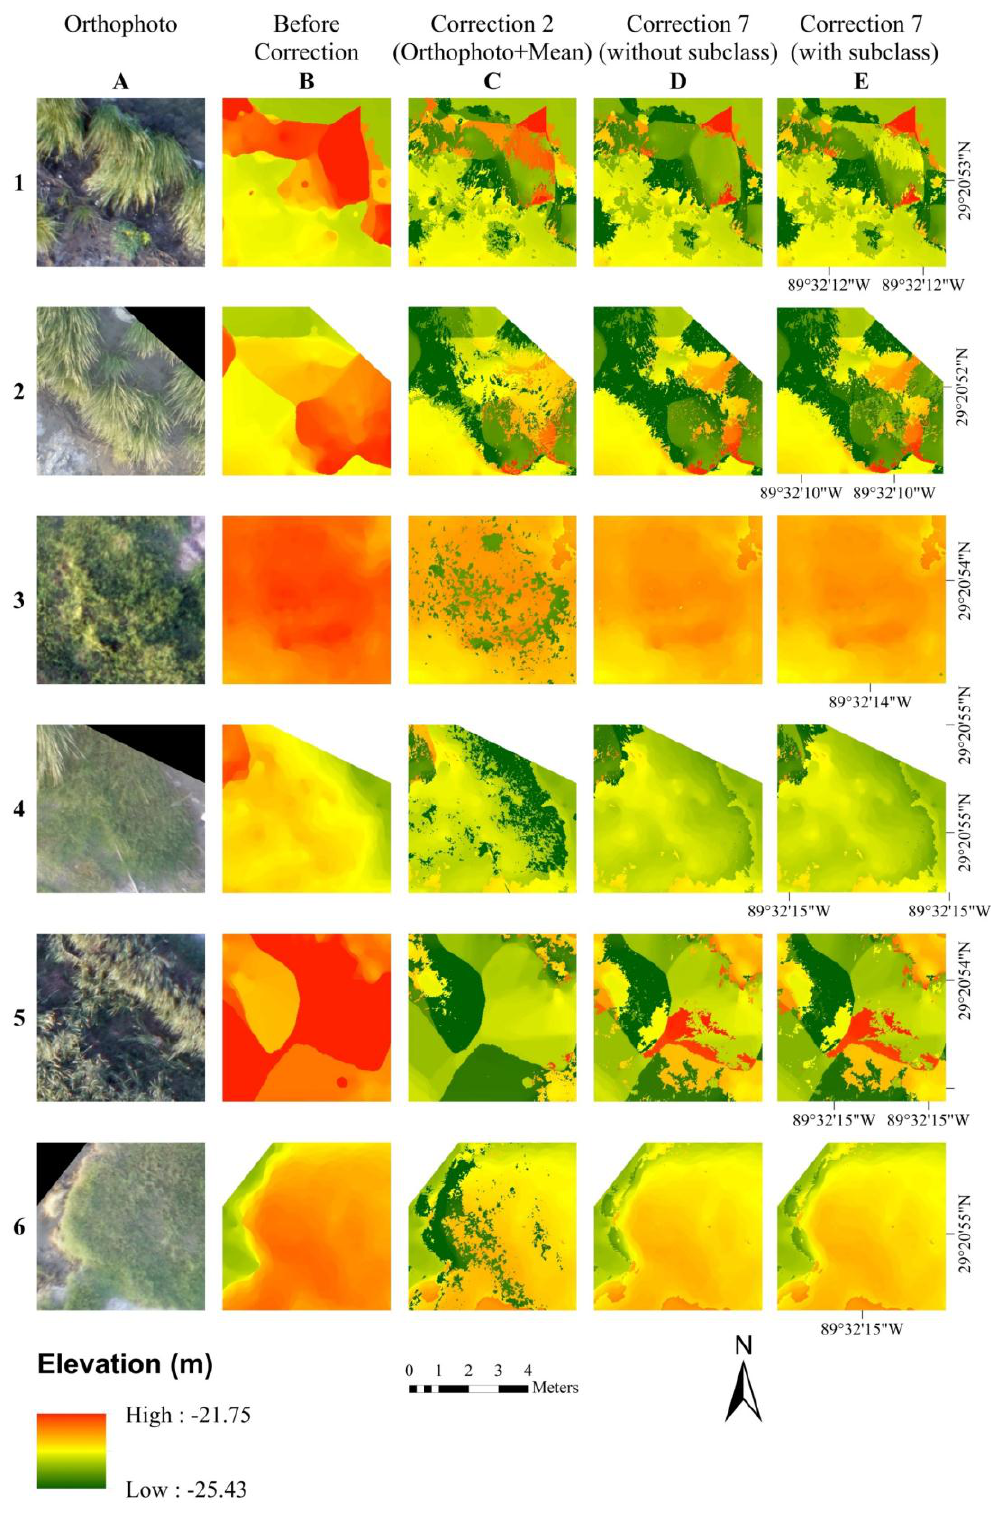
Figure 9. Comparison of terrain correction effects based on different classification methods. Correction 2 and Correction 7 correspond to the correction results based on Classification 2 and Classification 7, respectively.